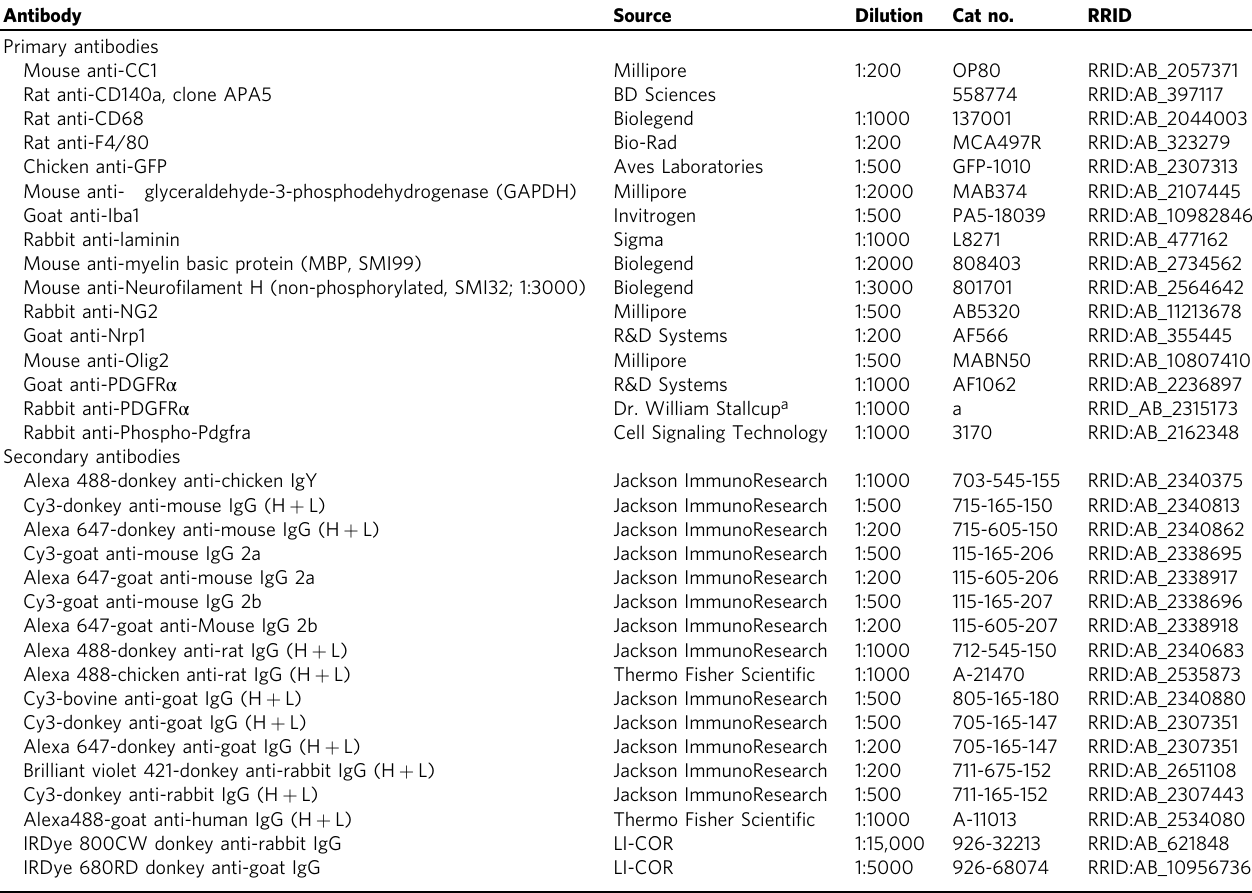
Table 1 Primary and secondary santibodies used.